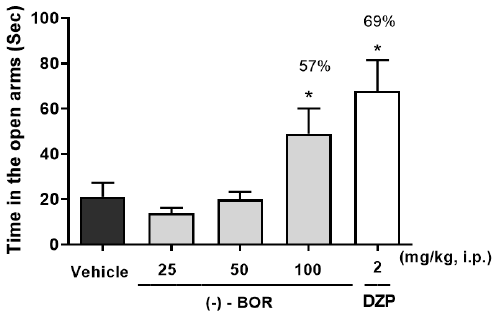
Figure 2. The effect of (–)-BOR (25, 50, and 100 mg/kg, i.p.) and DZP (2 mg/kg, i.p.) on the elevated plus maze test with mice ( n = 6). Each bar represents the mean ± SEM of time in seconds (sec) in which the animals remained in the open arms. * p < 0.05 is significant compared to the vehicle group (ANOVA and t-Student-Newman-Keuls test as post hoc test).